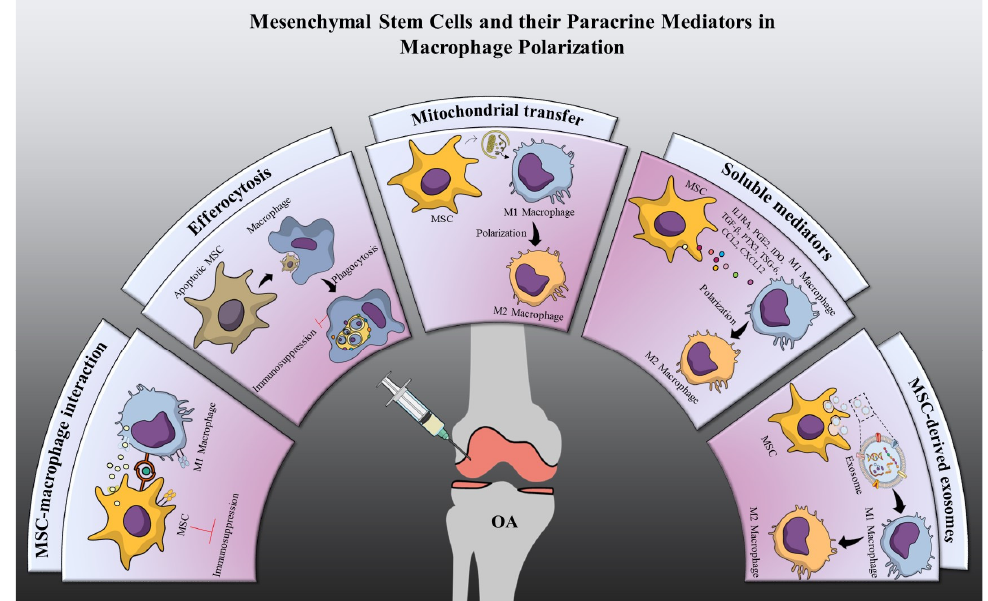
Figure 2. Schematic representation of mesenchymal stem cells (MSCs) and their paracrine mediators in macrophage polarization. MSCs exert immunosuppressive effects by switching pro-inflammatory M1 macrophages to anti-inflammatory M2 macrophages through (1) MSC-macrophage interaction: Immunosuppression is triggered by adhesion receptors and calcium signaling following a functional contact between MSC and an inflammatory M1 macrophage. (2) Efferocytosis: Apoptosis and efferocytosis of MSCs induces metabolic and inflammatory alterations in macrophages, resulting in immunosuppression. (3) Mitochondrial transfer: Induces functional alterations in macrophages and improves the immune-regulatory activity by M2 macrophage activation. (4) Soluble mediators: Enhances macrophage immunomodulation by reducing pro-inflammatory M1 state and maintaining anti-inflammatory M2 phenotype. (5) Exosomes: The exosomal cargo and molecular contents have the capacity to influence the macrophage